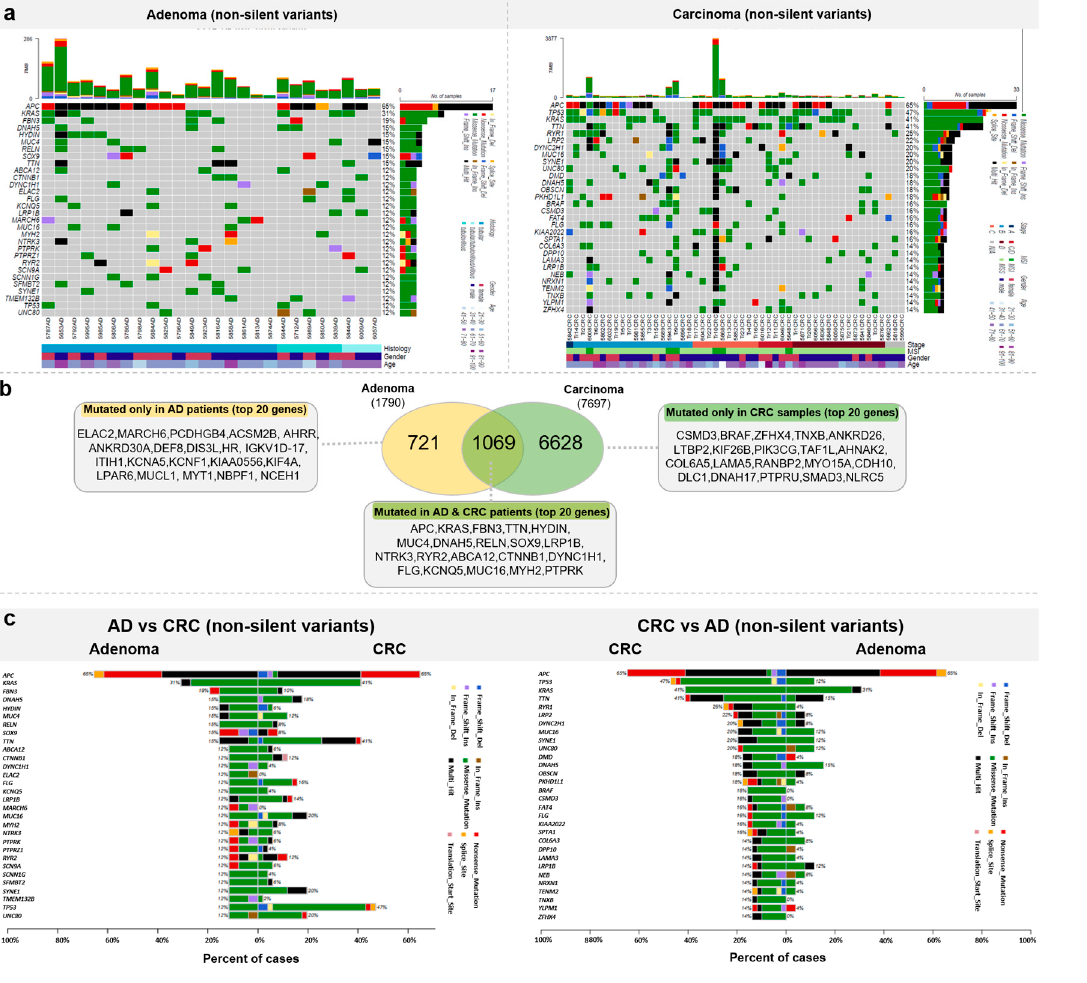
Figure 4. Somatic mutation landscape of colorectal tumors. ( a ) Most frequently mutated genes in adenomas and CRCs ( b ) Venn diagram representation of the number of genes mutated exclusively in one sample group or in both ADs and CRCs with the list of the 20 most frequently mutated genes. ( c ) Direct comparison of AD and CRC samples based on the top 20 most frequently mutated genes in AD (left) and CRC (right).